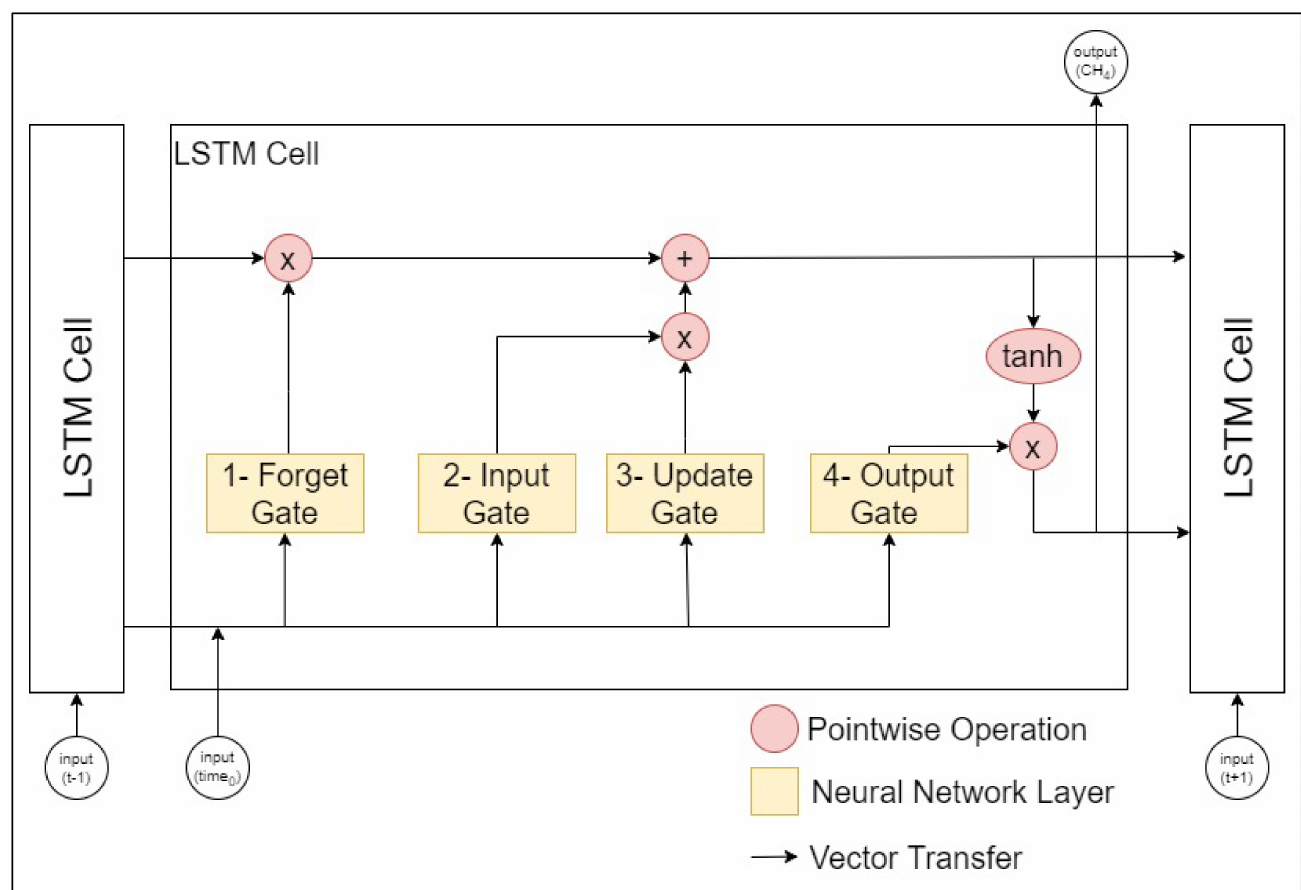
Figure 4. Simplified LSTM architecture (modified from [37]).